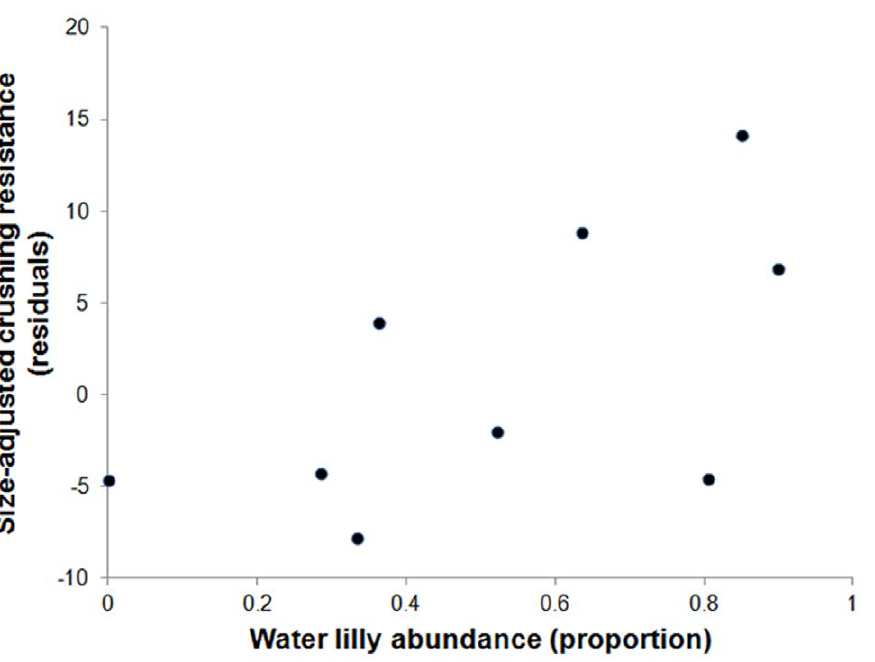
Figure 2. Relationship between water lily abundance and size-adjusted crushing resistance in Cuatro Cie´negas, Mexico. Each point represents a different population (N=9).